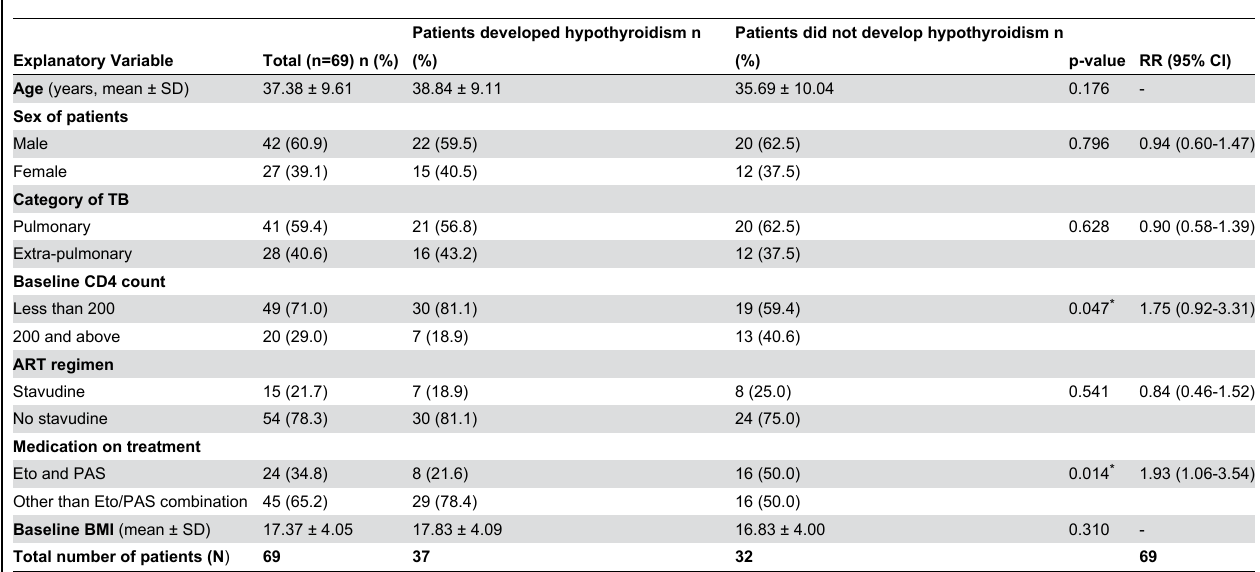
Table 1. Bi-variate analysis for development of hypothyroidism during treatment among HIV/MDR-TB co-infected patients, Mumbai, India, 2013.